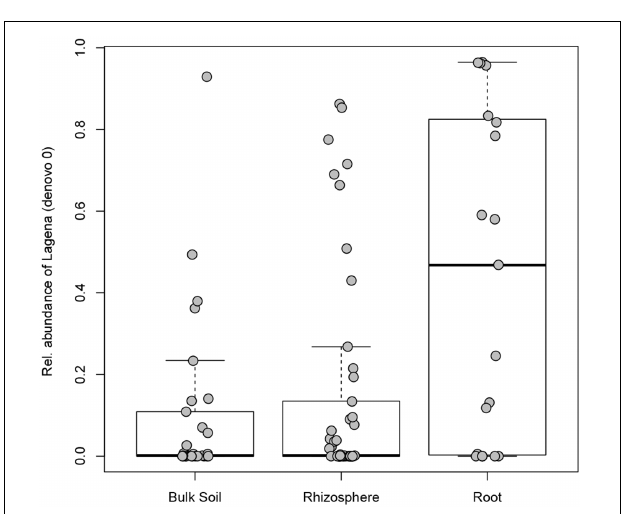
FIGURE 3 | Boxplot showing the relative abundance of the most abundant taxa of oomycetes communities at order, family, and genus levels. Box borders represent the first and third quartiles, and central lines represent medians.